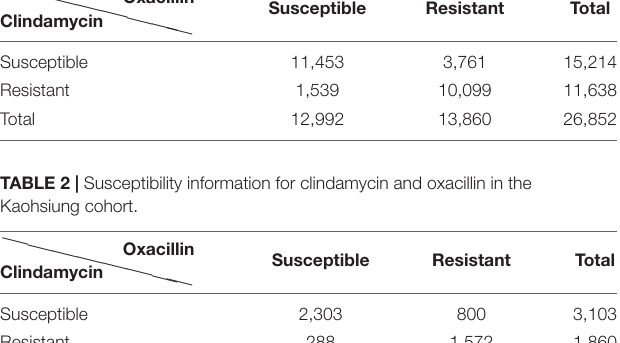
TABLE 1 | Susceptibility information for clindamycin and oxacillin in the Linkou cohort.